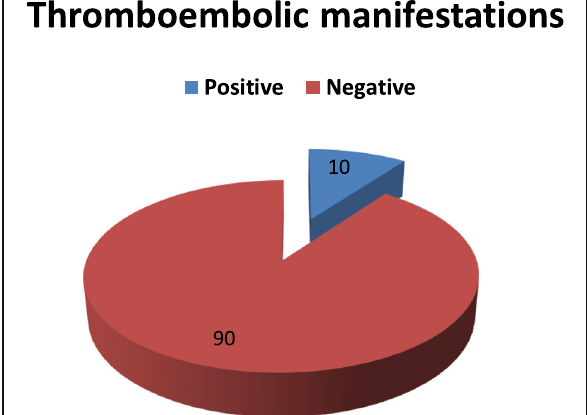
Fig. 1 Prevalence of thromboembolic manifestations among COVID-19-positive patients